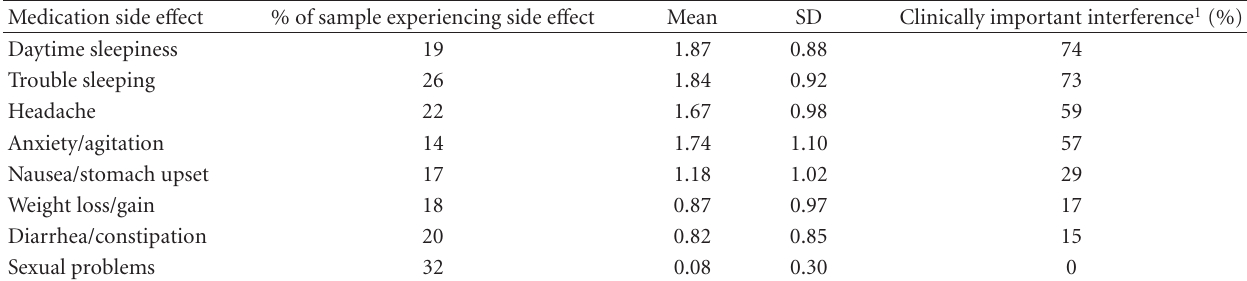
Table 3: Summary of responses ( N = 164) from questionnaire relating medication side e ff ects ( > 9% prevalence) to interference in work